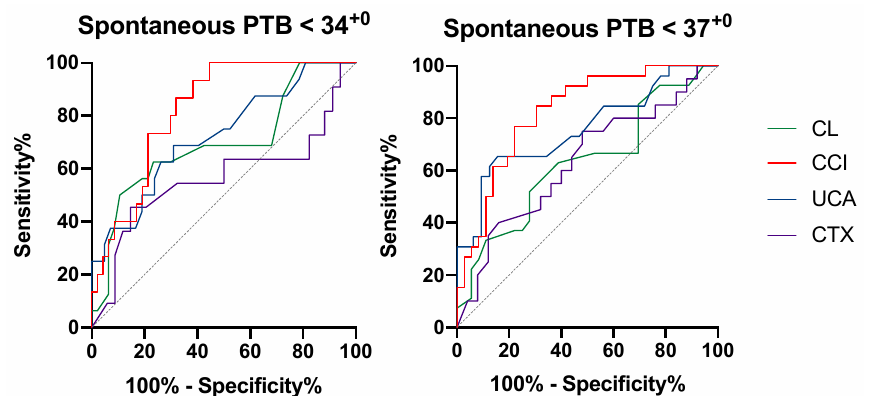
Figure 3. Receiver operating characteristic (ROC) curves for the cervical length (CL), cervical consistency index (CCI), utero-cervical angle (UCA), and cervical texture (CTx) and with regard to predicting spontaneous preterm birth (sPTB) before 34 + 0 and before 37 + 0